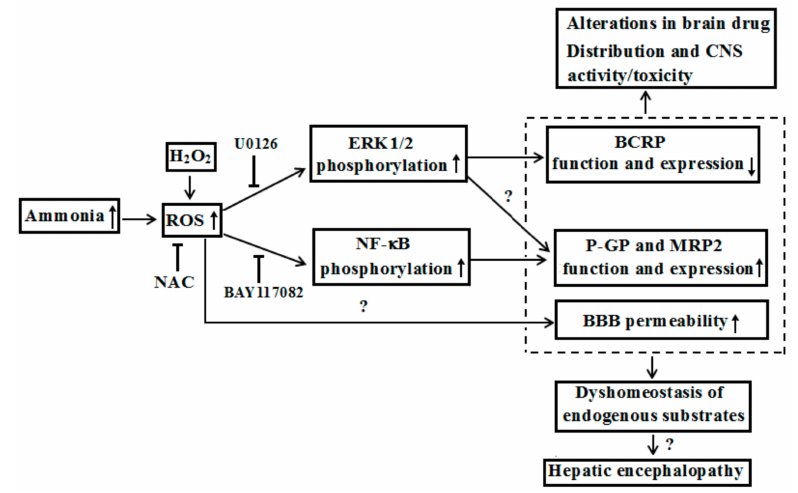
Figure 3. Possible mechanisms that hyperammonemia altered expression and function of ABC transporters at BBB under liver failure and its contributions to hepatic